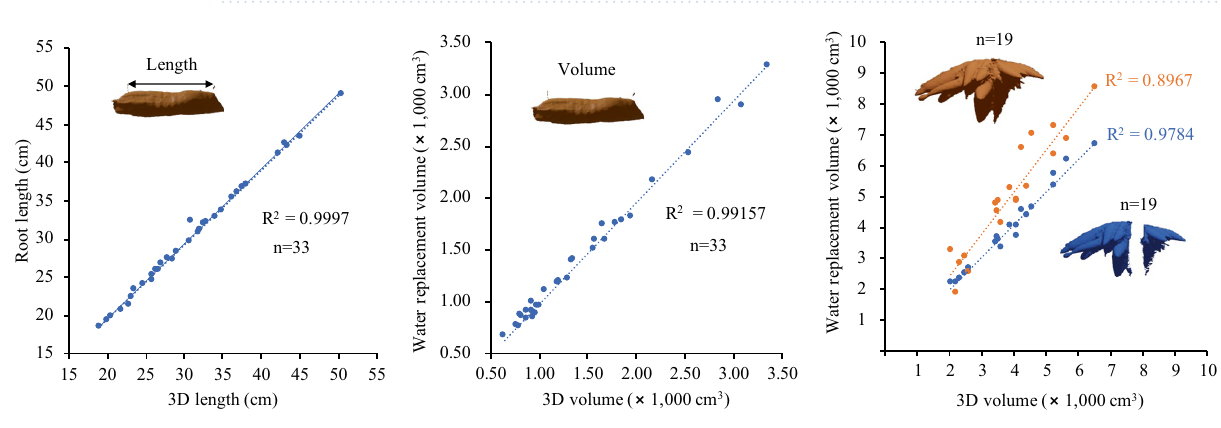
Figure 6. Validation of measurements for lengths and volumes of cassava roots and root crowns. Scatter plots show data for ground truth measurements and 3D calculations for root lengths, root volumes and root crown volumes, respectively. For the root crown volume, intact and split crowns are